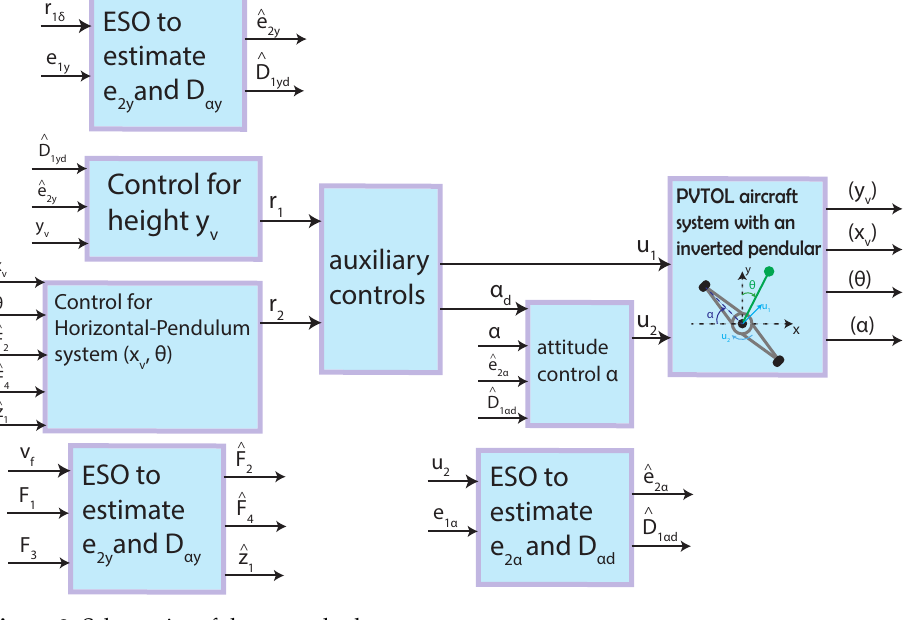
Figure 2. Schematics of the control